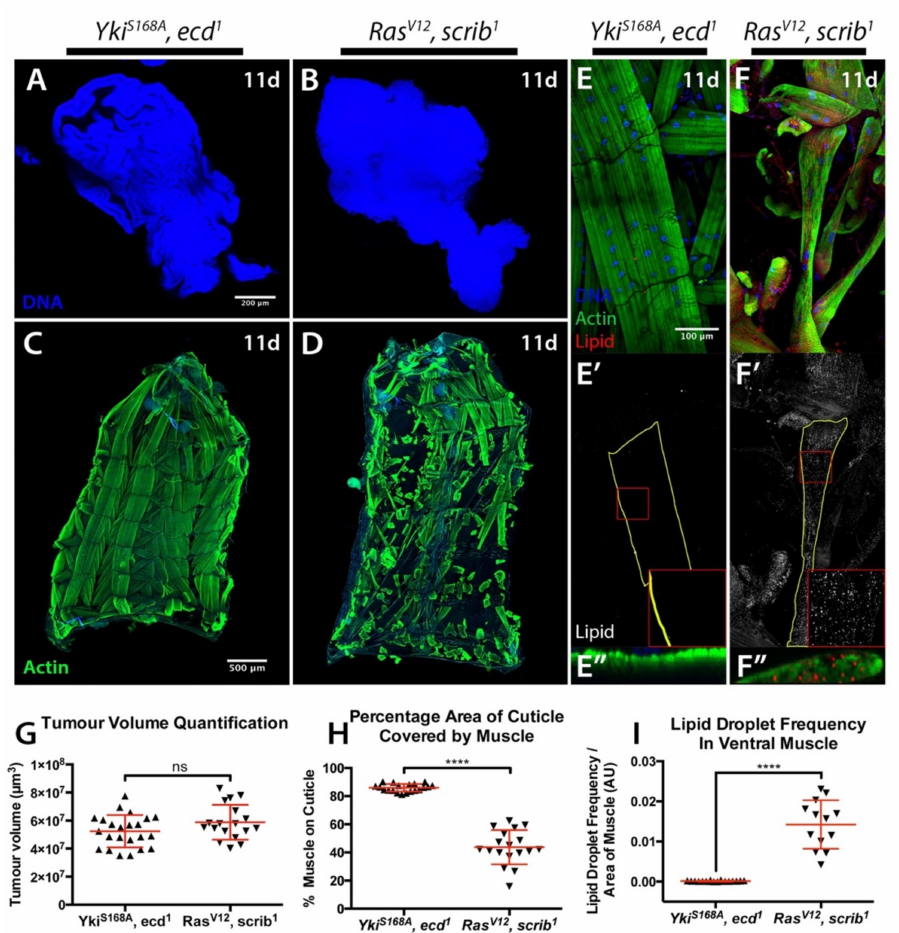
Figure 2. Tumour size is not sufficient to drive cachexia. ( A , B ) Tumours stained with DAPI. rotund > Yki S168A tumours induced in an ecd 1 mutant background ( A ), and MARCM eye Ras V12 , scrib 1 tumours ( B ), both at 11 days AED. ( C , D ) Cuticles from animals as in ( A , B ), with muscle actin stained with Phalloidin (green). ( E – F (cid:48)(cid:48) ) 5th segment of the 7th ventral muscle, stained with DAPI (blue), Phalloidin (green), and LipidTOX (red or grey). Animal ages and genotypes as in ( A , B ). Panels denoted ( (cid:48) ) show lipid staining only. Panels denoted ( (cid:48)(cid:48) ) show a transversal orthographic view of muscle with a 2X zoom. ( G ) Tissue volume quantification. ( H ) Quantification of the percentage of the cuticle covered by muscle. ( I ) Quantification of the frequency of IMLDs in the 5th segment of the 7th ventral muscle, expressed as a ratio over the area of that muscle. All graphs show t test. Mean ± SEM is indicated. ns: non-significant, p > 0.05; **** p ≤